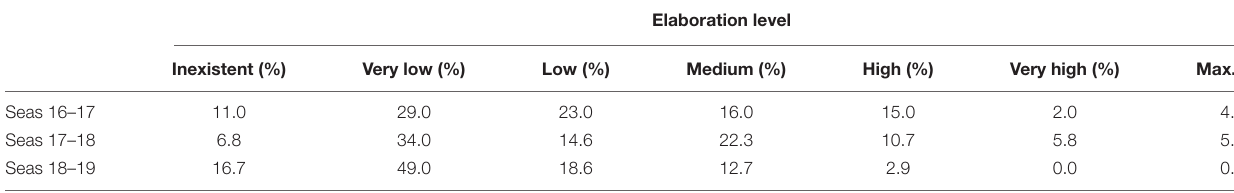
TABLE 10 | Contingency table: Season * Elaboration level.